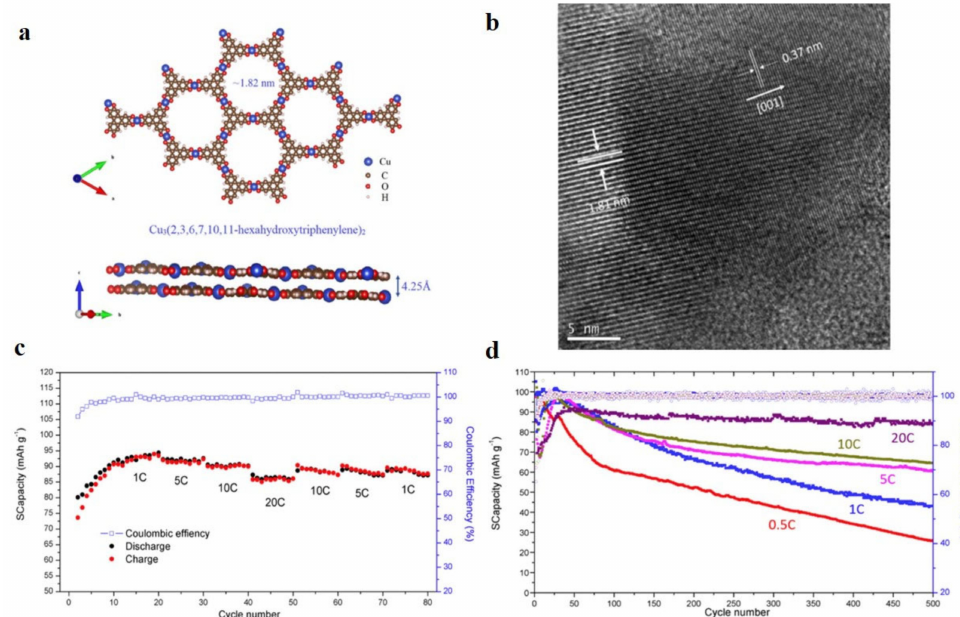
Figure 8. ( a ) Crystal structure of Cu 3 (HHTP) 2 from top and side views, ( b ) HR − TEM image of Cu 3 (HHTP) 2 , ( c ) the rate capability of Cu 3 (HHTP) 2 at current rates from 1 C to 20 C, ( d ) the cycling performance of Cu 3 (HHTP) 2 at different current rates for 500 cycles. Reproduced with permission from Ref. [83]. Copyright 2019 Elsevier